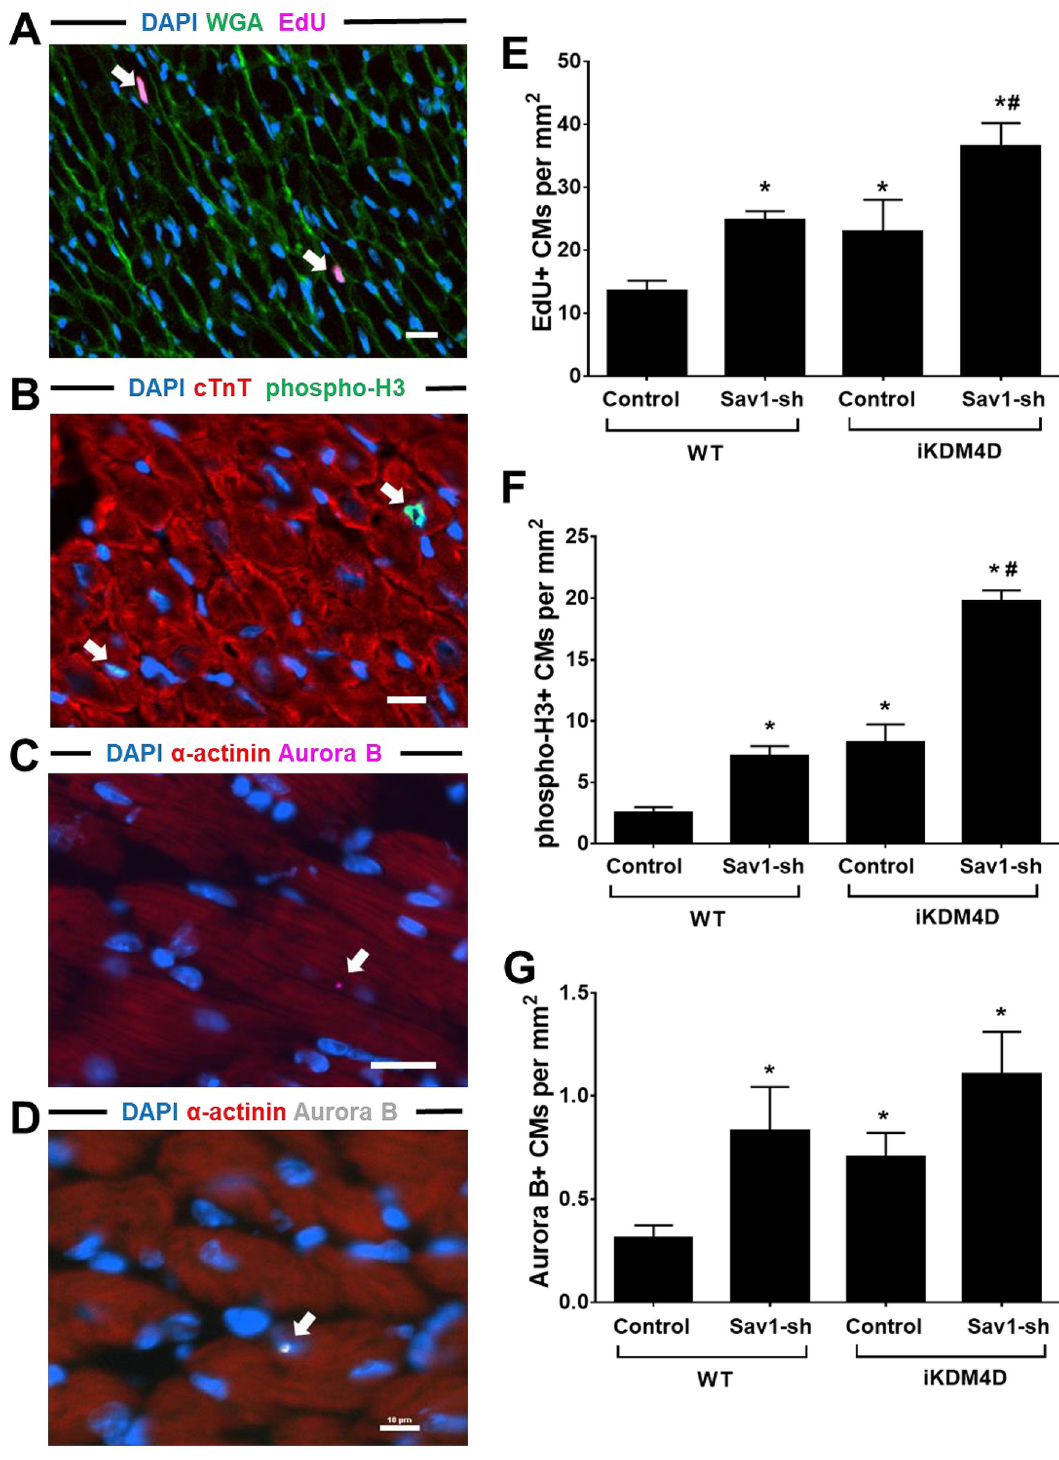
Fig 5. Additive effect of KDM4D overexpression and Sav1 knockdown on ACM cell cycle activity in vivo . (A, B, C, and D) Representative photomicrographs from iKDM4D+Sav1-sh hearts showing EdU, phospho-H3, and Aurora B immunostaing after KDM4D induction and Sav1 knockdown for 2 weeks. Nuclei were stained with DAPI (blue), cell borders with WGA (green), and cycling cells with EdU (magenta), white arrow points to the EdU + CMs in (A). Nuclei were stained with DAPI (blue), CMs with cTnT (red), and cycling CM with phospho-H3 (green), white arrow points to the phospho-H3 + CMs in (B). (C) Aurora B (magenta,